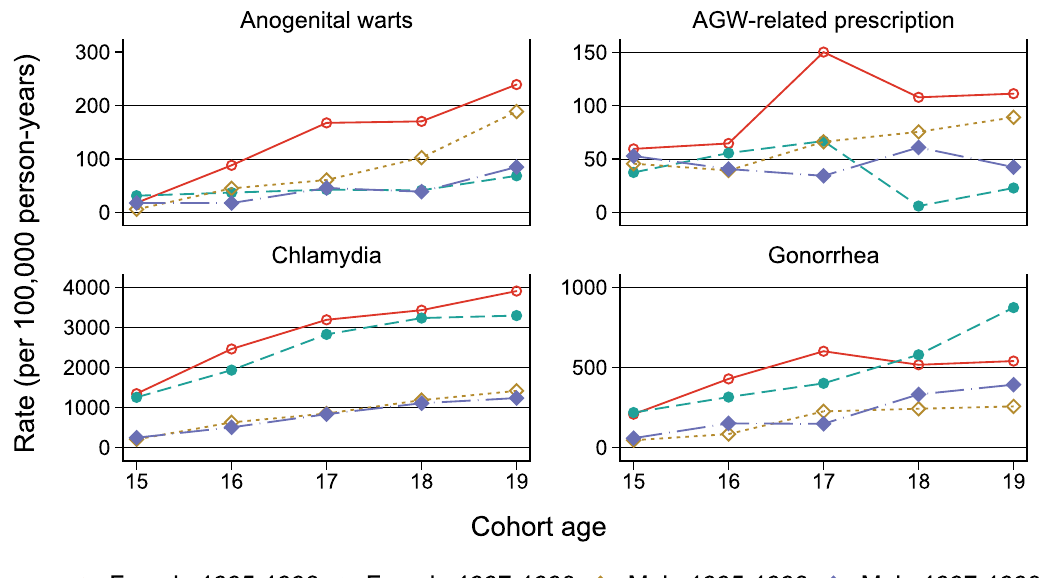
Fig 3. Incidence rates of conditions of interest by birth cohort, age, and gender. The 1995–1996 birth cohorts are the last cohorts not enrolled in the publicly funded school-aged vaccination program (prior cohort); the 1997–1998 birth cohorts are the first routinely enrolled cohorts (posterior